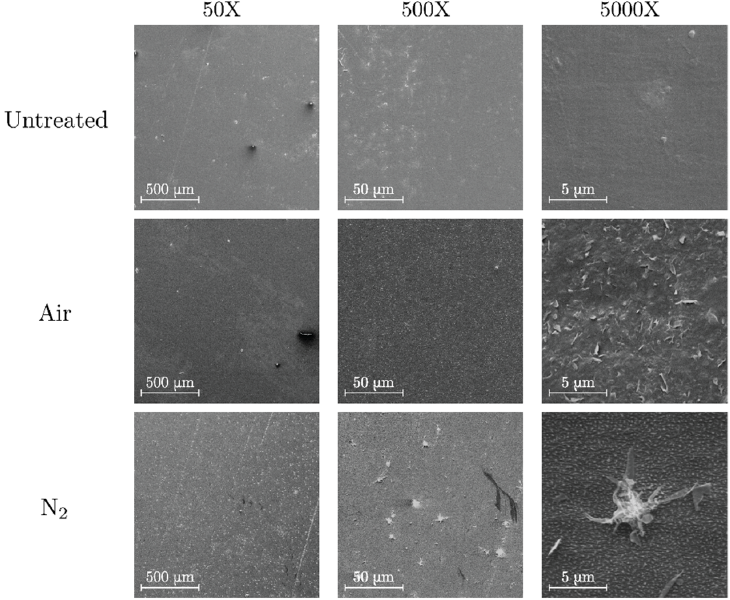
Figure 3. SEM images of untreated ( top ), air-treated ( center ) and nitrogen-treated ( bottom ) PP.